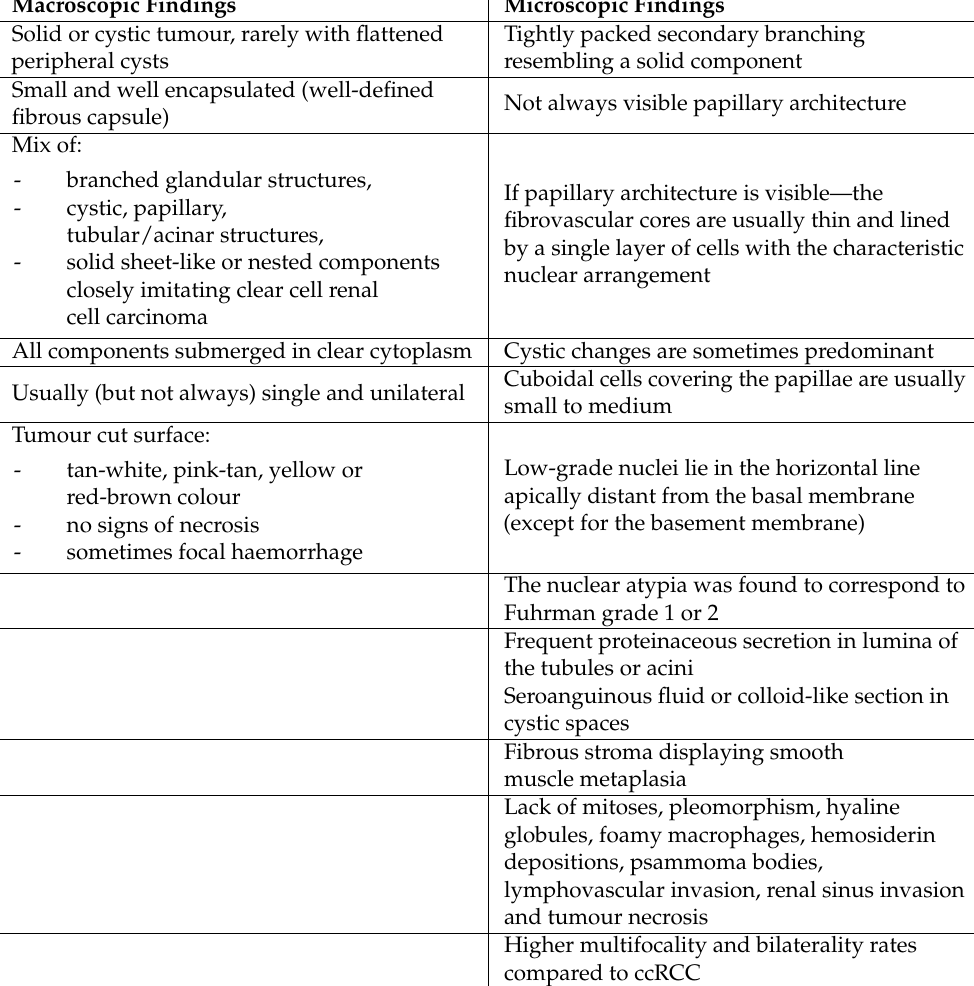
Table 1. The summary of macroscopic and microscopic features of